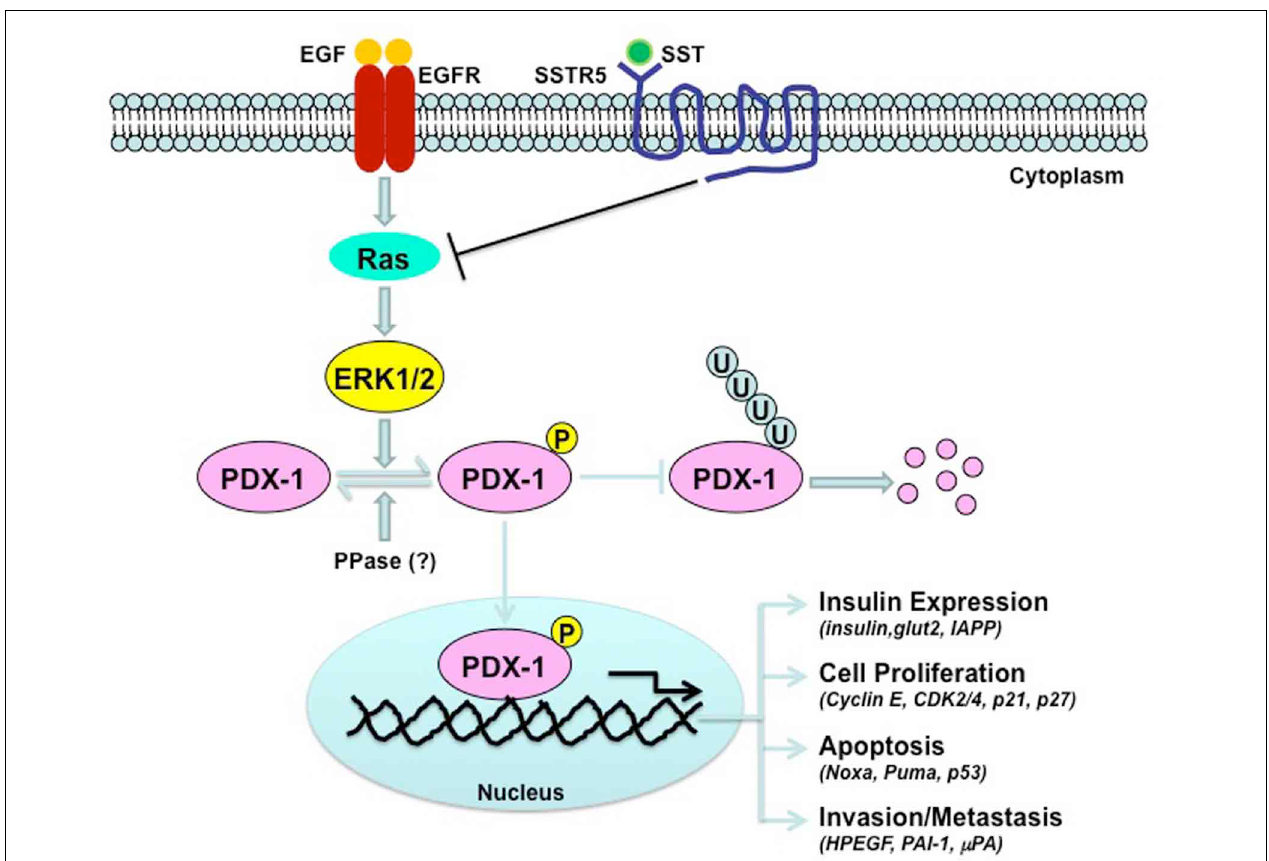
FIGURE 1 | Schematic depiction of the down-regulation of PDX-1 by SSTR5. Epidermal growth factor (EGF) stimulates kinase activation of ERK MAP kinase, which, in turn, interacts with and phosphorylates PDX-1, leading